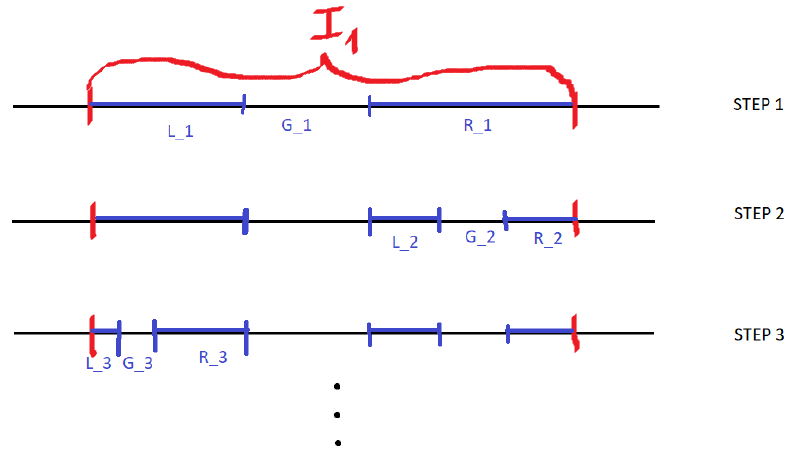
Figure 1. Construction of a compact